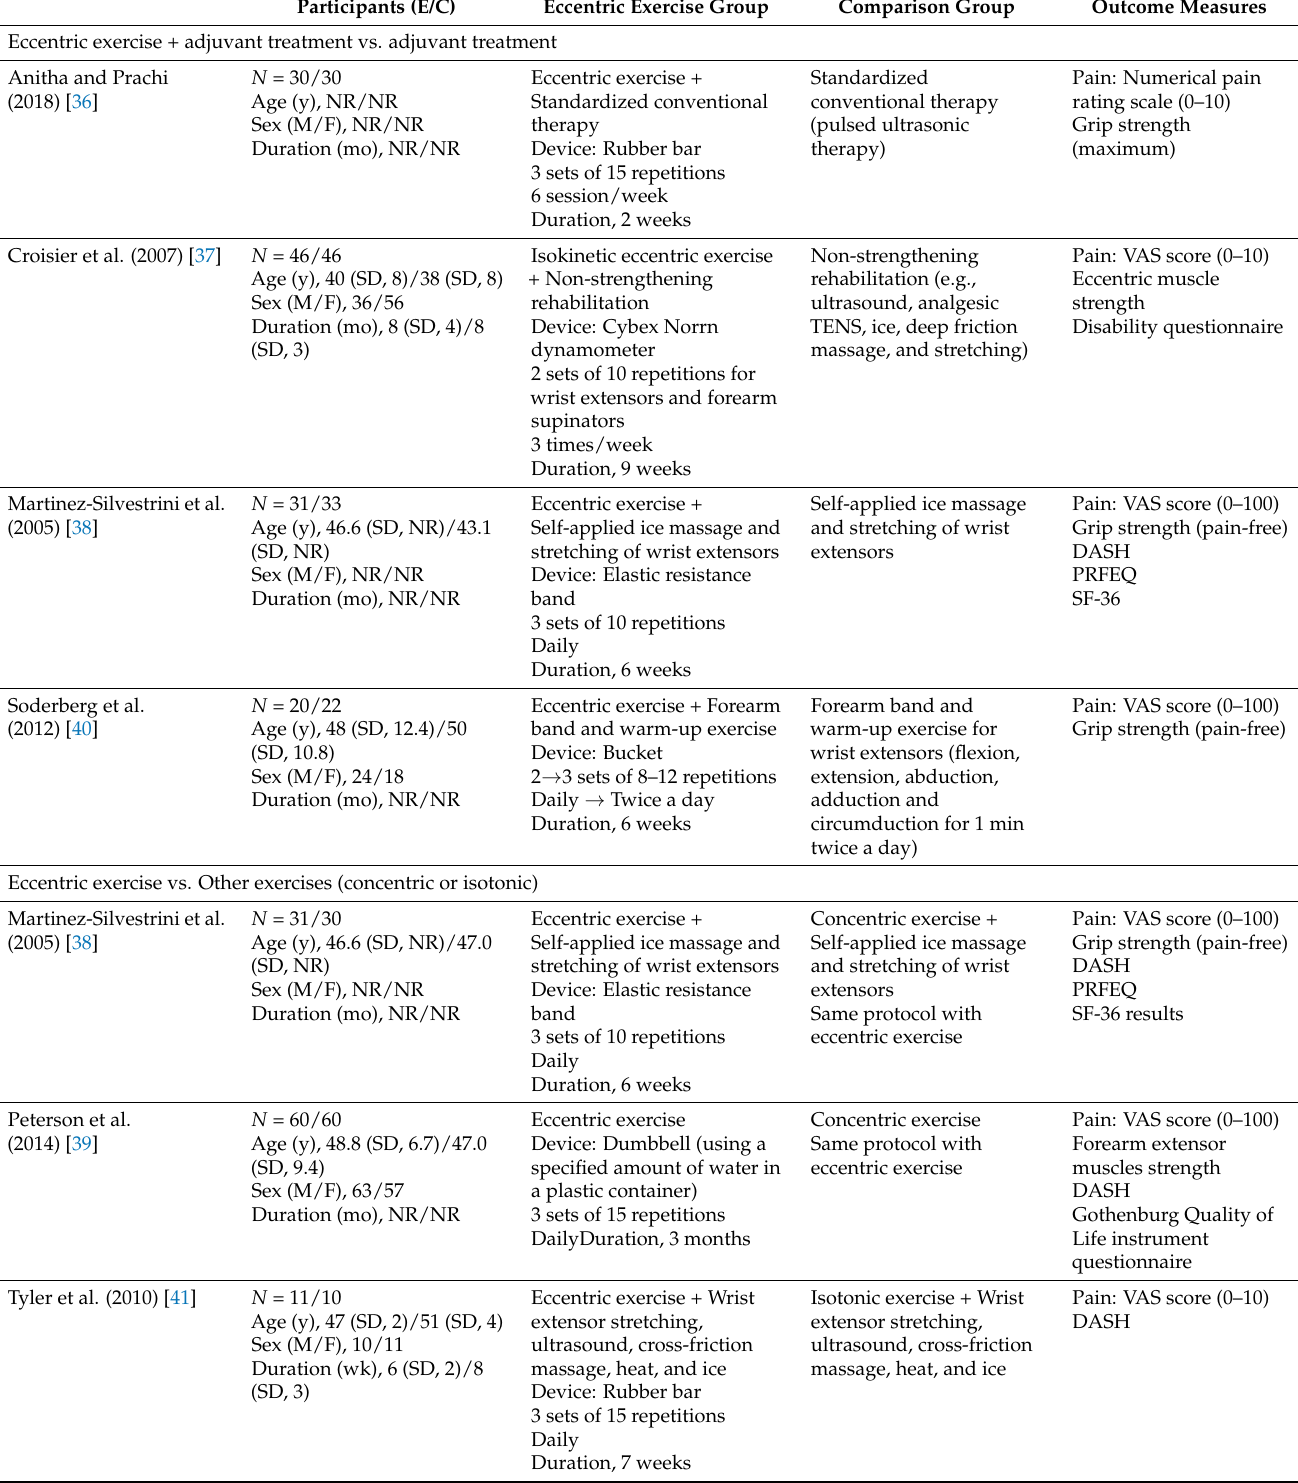
Table 1. Characteristics of the included